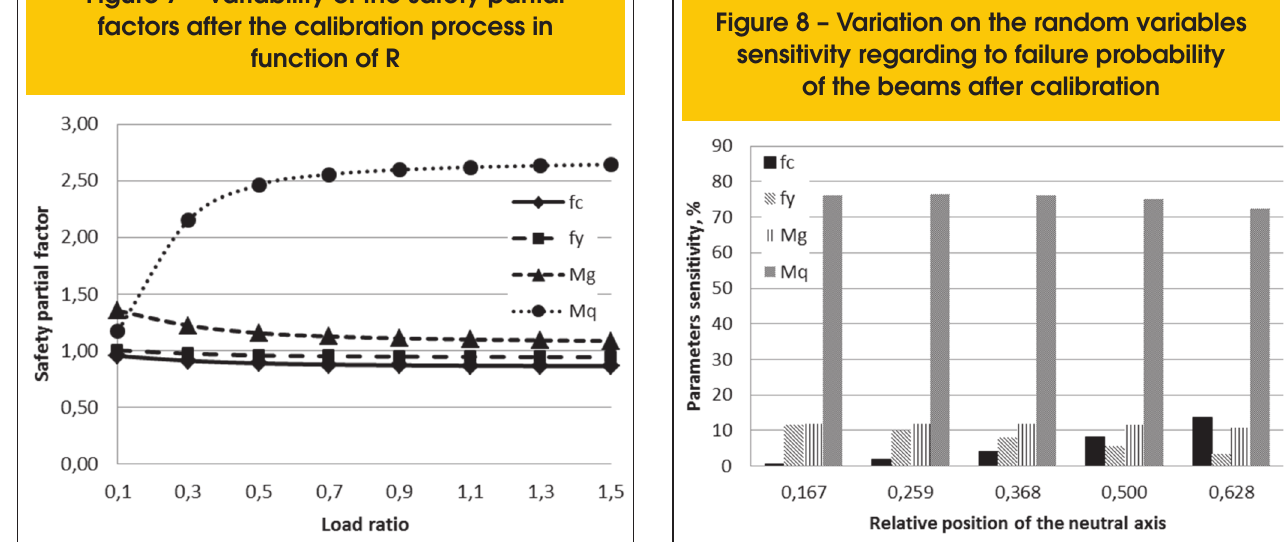
Figure 8 – Variation on the random variables sensitivity regarding to failure probability of the beams after